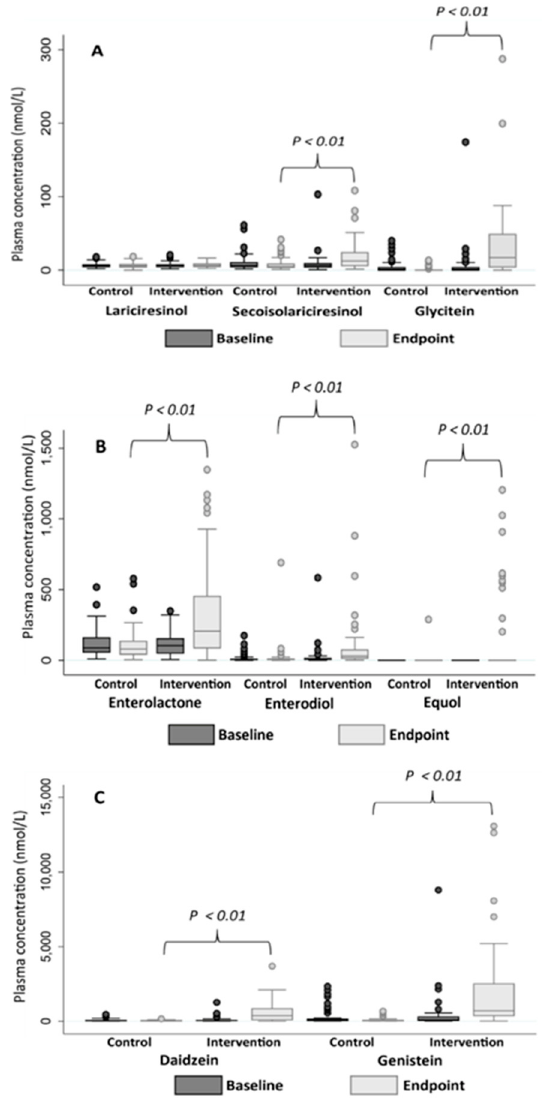
Figure 4. Boxplots showing plasma concentrations of different phytoestrogens (nmol/L) in the intervention- ( n = 51) and control groups ( n = 54) in patients with prostate cancer at baseline and endpoint. ( A ) Plasma concentrations of lariciresinol, secoisolariciresinol, and glycitein. ( B ) Plasma concentrations of enterolactone, enterodiol, and equol. ( C ) Plasma concentrations of daidzein and genistein. Concentrations of secoisolariciresinol, glycitein, enterolactone, enterodiol, equol, daidzein, and genistein were statistically significantly higher in the intervention group compared to the control group at the endpoint. The Mann–Whitney U test was used to test differences between